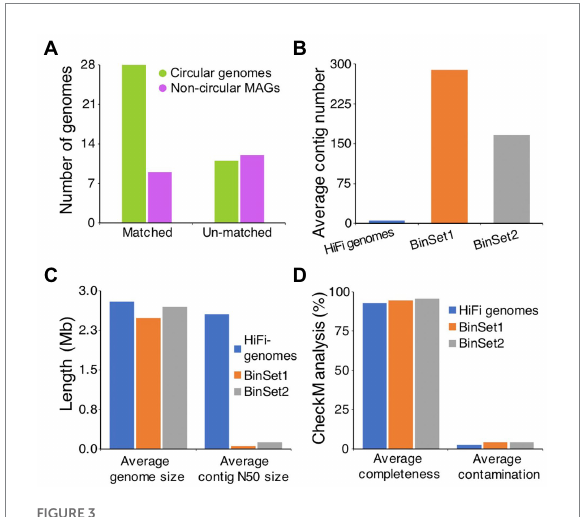
FIGURE 3 Comparison of HiFi assembled microbial genomes to the short- read assembled genomes. (A) Statistics of our assembled microbial genomes with matching relationship to the published short-read derived MAGs from anaerobic digestion. If one of our HiFi assembled microbial genome shows ANI value ≥ 95% to any of the published MAGs, it is supposed to match to the published MAG. Comparison of average contig number (B) , assembled genome size and contig N50 size (C) , and CheckM quality (D) between our HiFi assembled microbial genomes and the corresponded matching MAGs from two published datasets. BinSet1 published by Campanaro et al. (2020) contains 1,401 MAGs, and BinSet2 published by Ma et al. (2021) contains 2,426